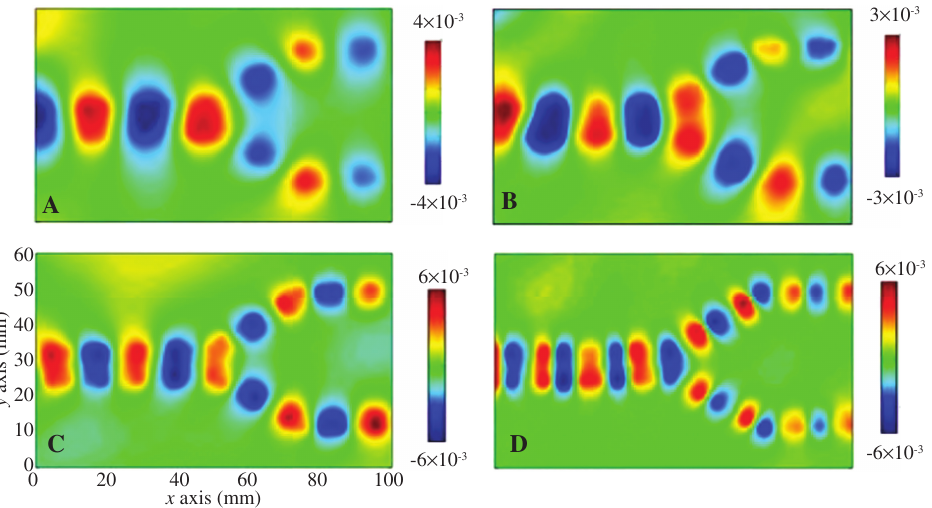
) of the planar plasmonic beam splitter in frequency ranging from 7 GHz to 11 GHz. Figure 9: Measurement results of electric field ( E z (A) 7 GHz; (B) 8 GHz; (C) 9 GHz; (D) 11 GHz. Reproduced from [40] with